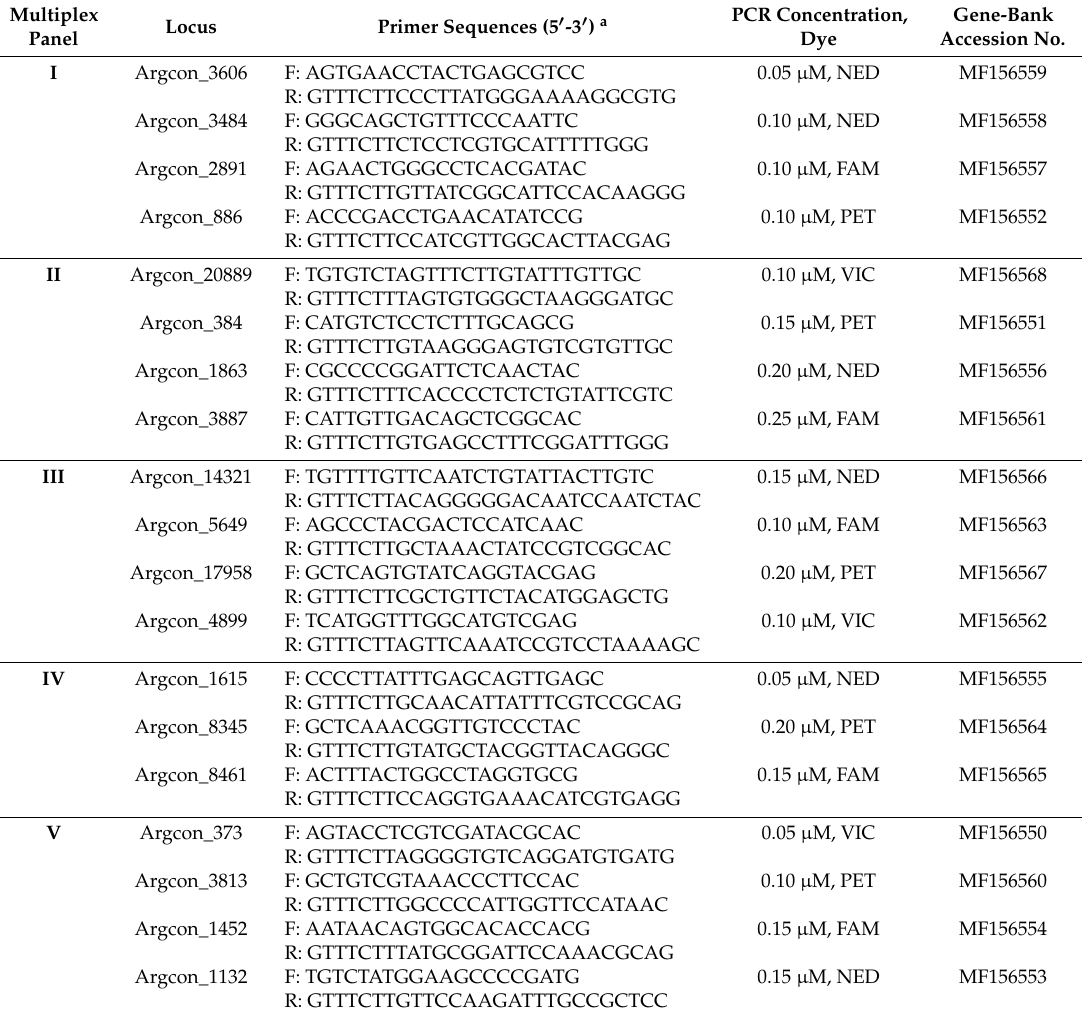
Table 2. Five multiplex PCR panels (I to V) for the 19 STRs from Argyresthia conjugella. Primer combinations, primer concentrations and fluorescent dye for the STRs used in each multiplex